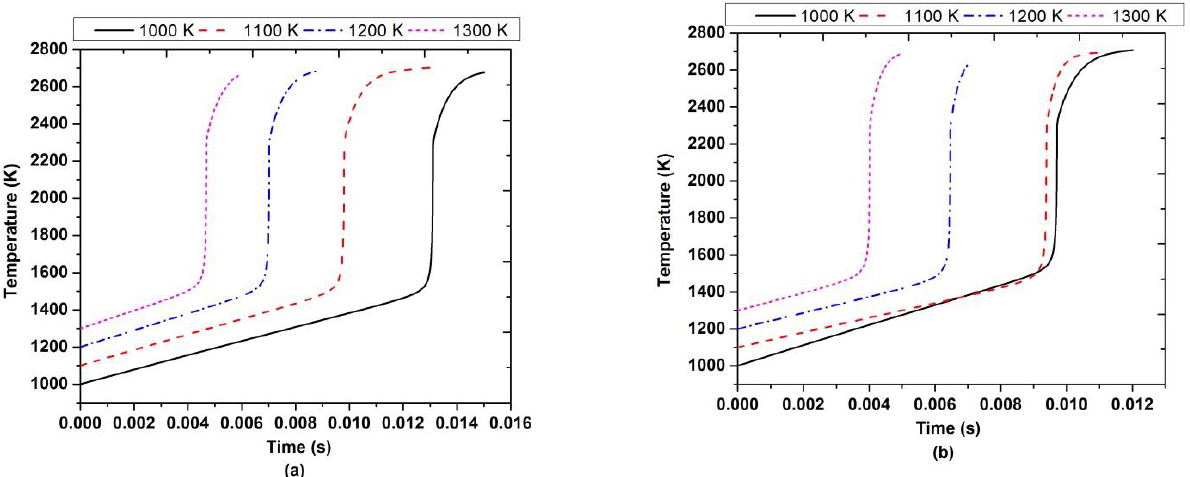
Figure 14. Comparative anlaysis of ignition delay time in presence of PAI at different inlet tempera-